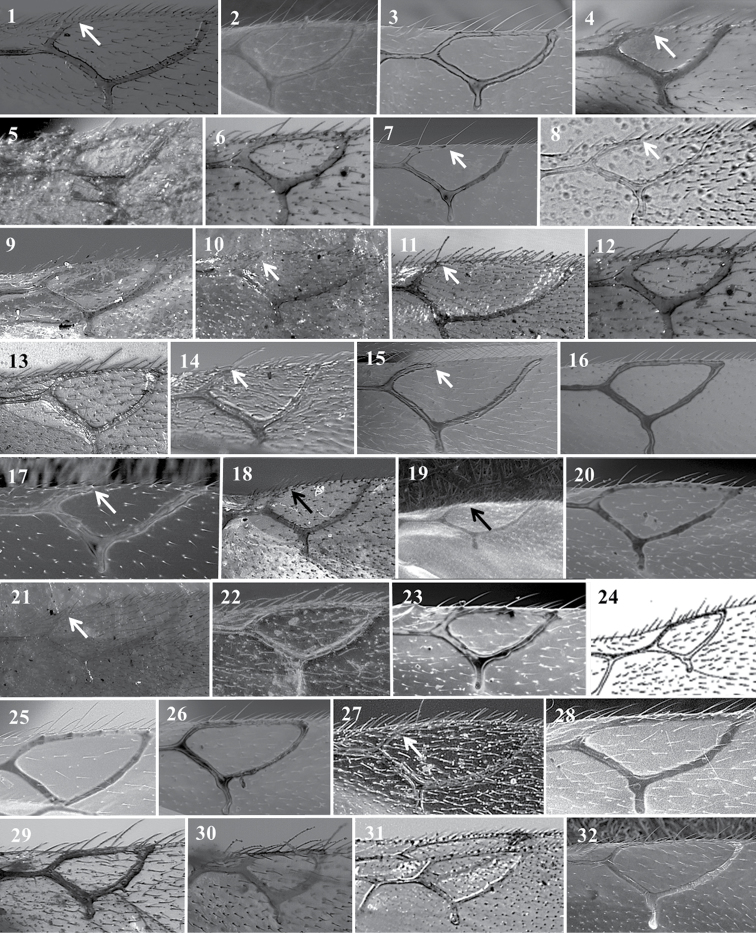
Alloxysta radial cell. A.abdera (1); A.andrewsi (2); A.antananarivoi (3); A.antsirananae (4); A.aperta (5); A.arcuata (6); A.asiatica (7); A.aurata (8); A.australiae (9); A.basimacula (10); A.brachycera (11); A.brevis (12); A.brevitarsis (13); A.carinata (14); A.castanea (15); A.circumscripta (16); A.citripes (17); A.commensuratus (18); A.costaricensis (19); A.consobrina (20); A.crassa (21); A.crassicornis (22); A.darci (23); A.desantisi (24); A.evenhuisi (25); A.fracticornis (26); A.fuscipes (27); A.hansoni (28); A.hendrickxi (29); A.heptatoma (30); A.japonicus (31); A.kovilovica (32).